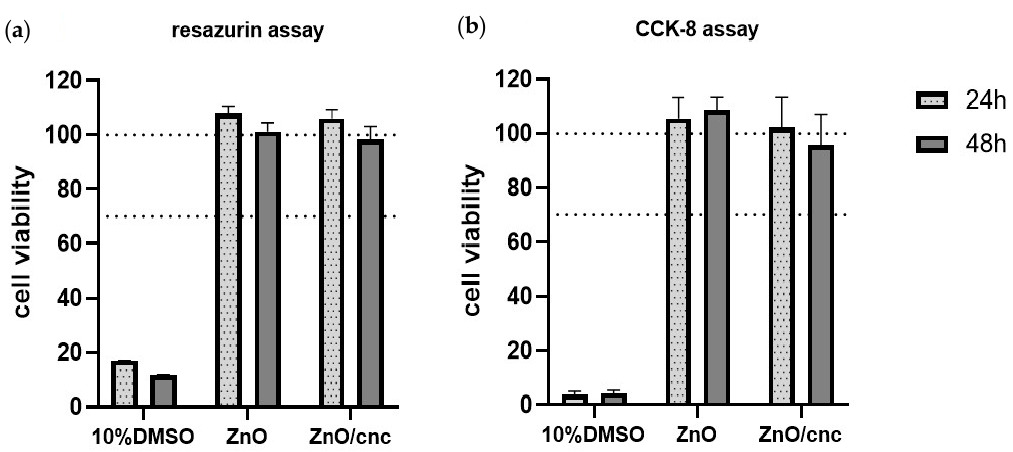
Figure 5. Cytotoxicity assay of the active multilayer films with and without cellulose nanocrystals (CNC) coatings. Cell viability was assessed by the resazurin assay ( a ) and cell counting kit- (CCK-8) assay ( b ) on Caco-2 cells after incubation for 24 and 48h at 37 °C. Values reported as Mean ± SD (N = 8).